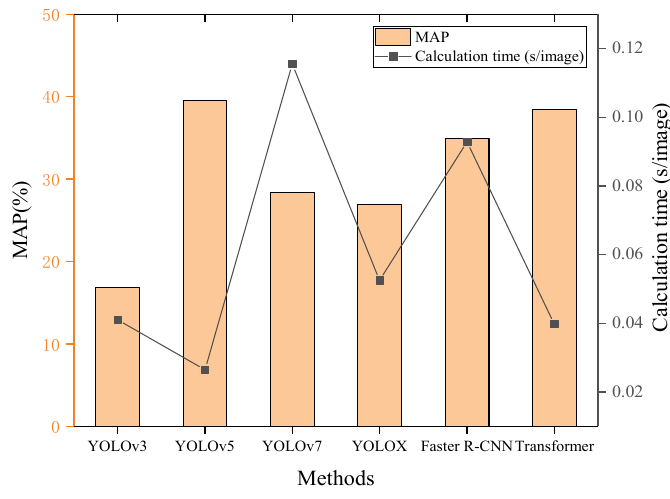
Figure 10. Performance comparison of different algorithms.